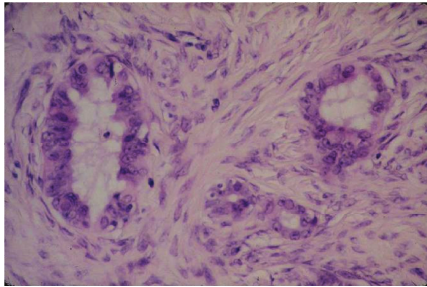
Figure 1: Nuclear abnormalities in ovarian epithelial dysplasia (HES, × 40), from Dr. L. Deligdisch